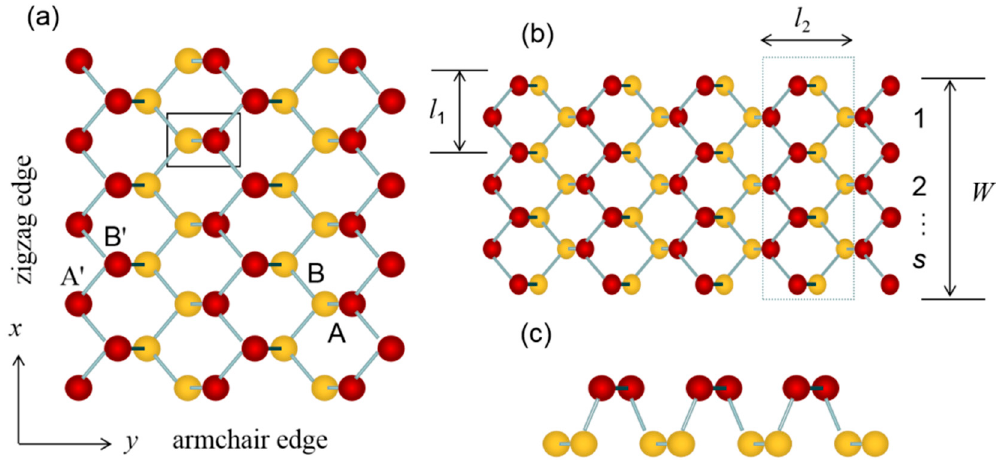
Figure 1. Crystal structure of a black phosphorus sheet. ( a ) Top view. The sublattices A and B (A' and B') are at the bottom (top) of the monolayer structure. ( b ) Armchair black phosphorus nanoribbon. A dotted rectangular denote the unit cells. ( c ) Side view.